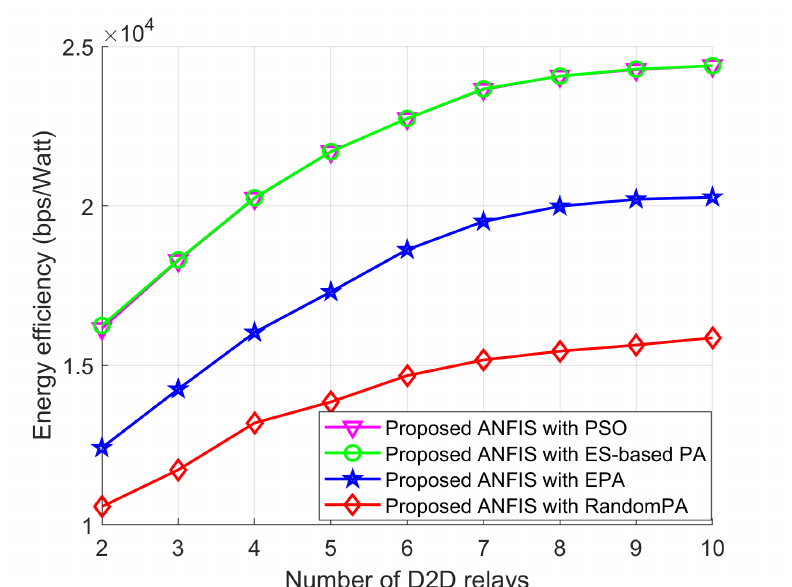
Figure 14. EE performance with L .